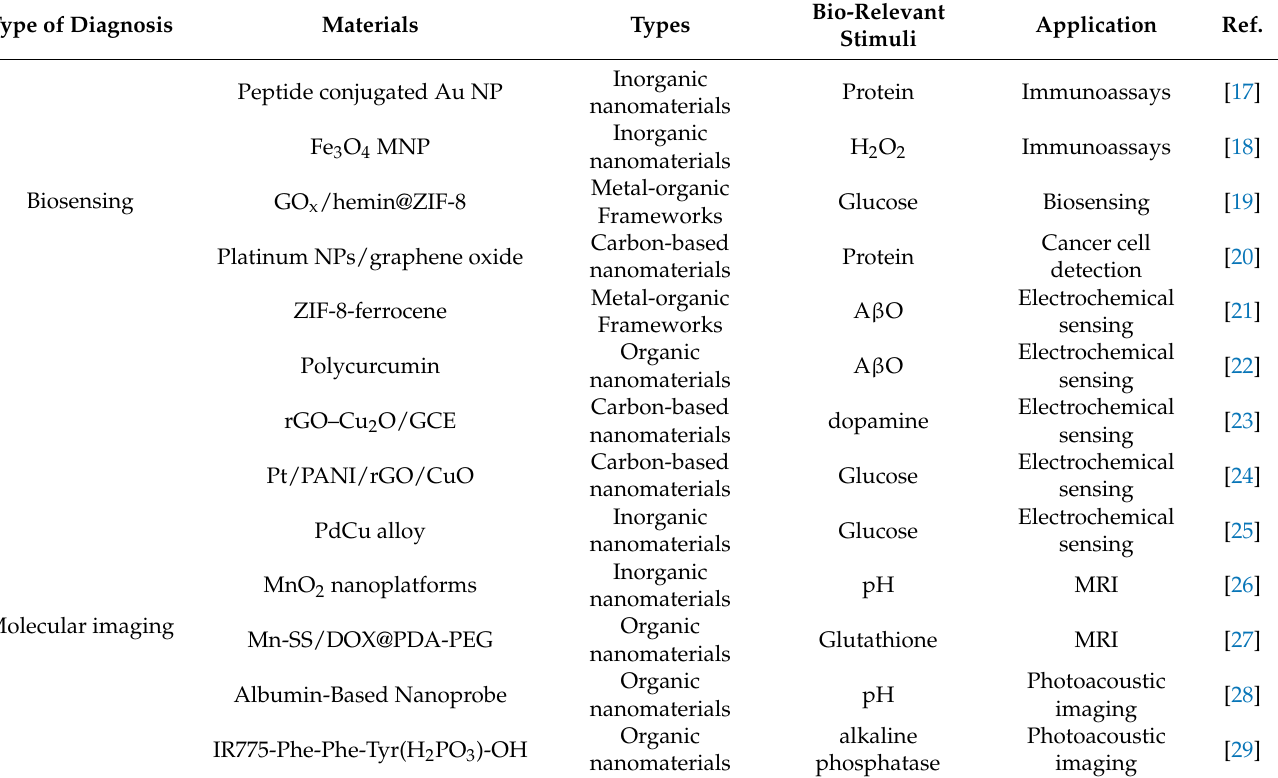
Table 1. Advanced biological responsive nanomaterials and their diagnostic